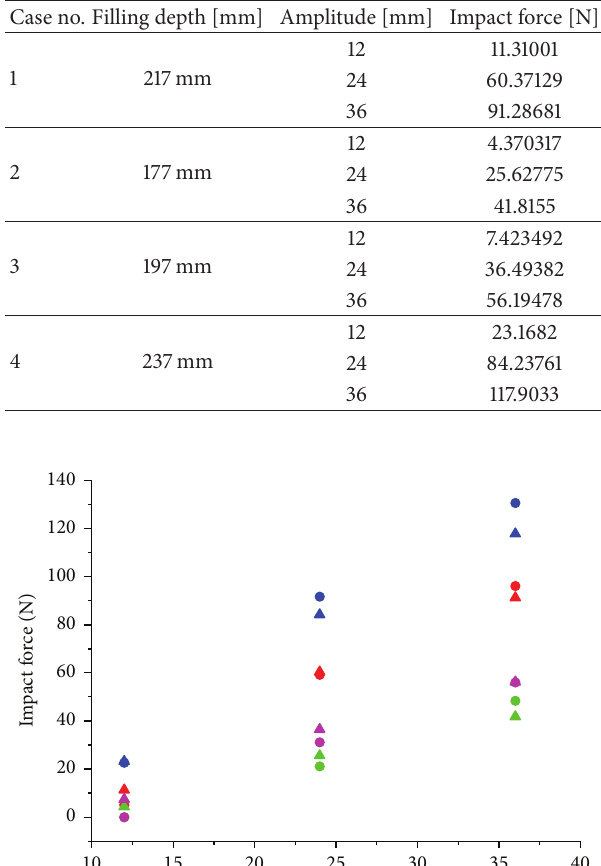
Table 4: Total impact force from measuring data.